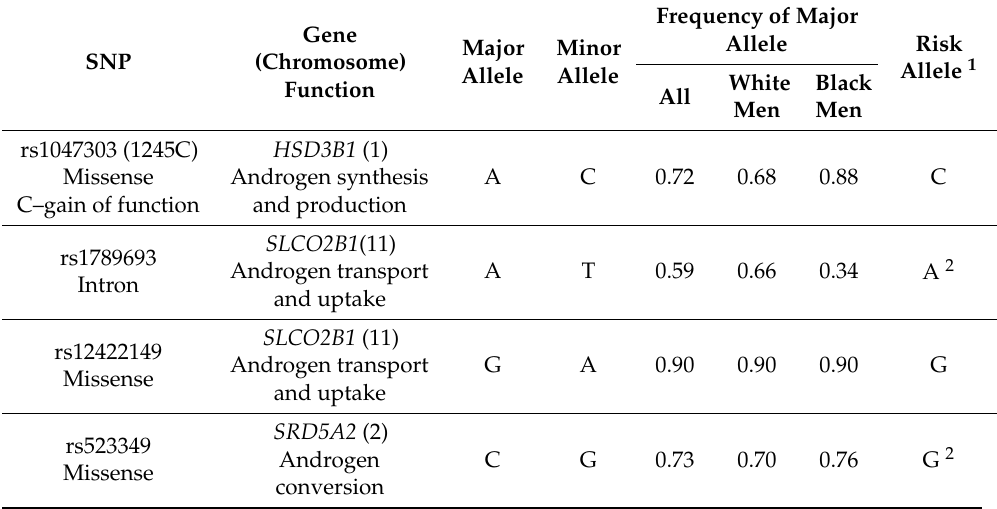
Table 2. Single nucleotide polymorphisms (SNPs) in the androgen-regulating genes,